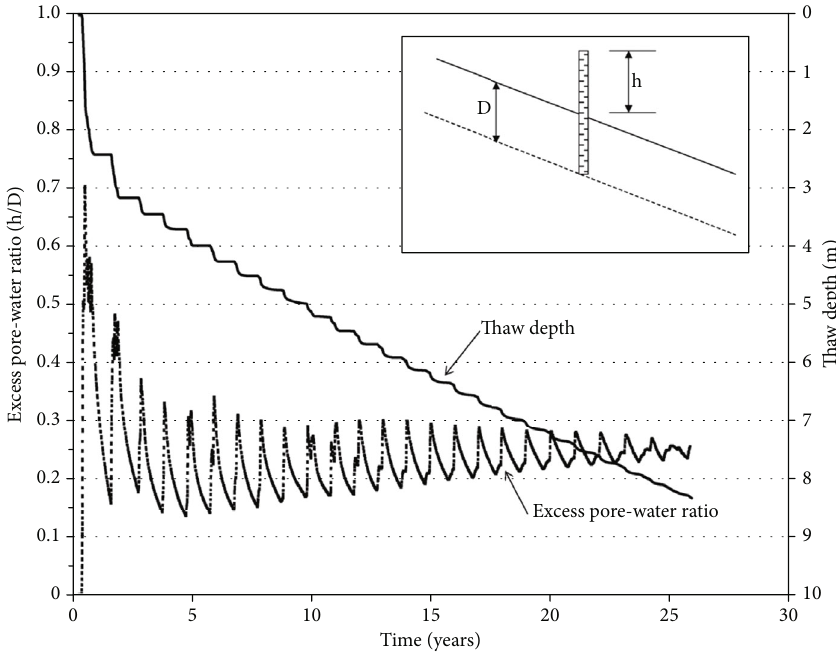
Figure 7: Excess pore water pressure and thaw depth with time as a result of thawing permafrost